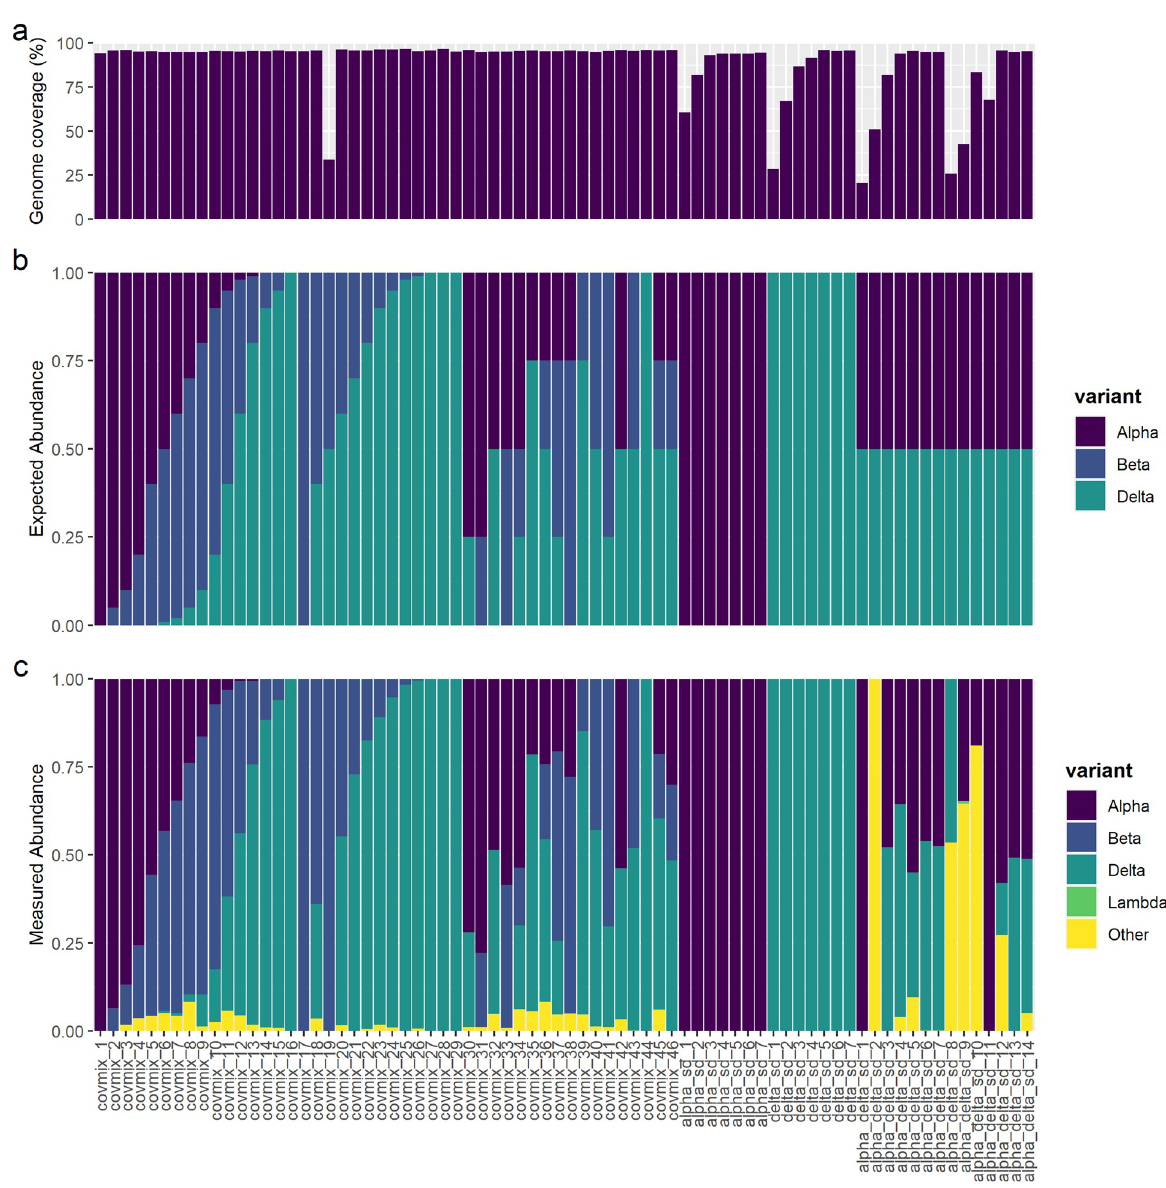
Fig 6. Wastewater sequencing protocol can successfully decipher synthetic SARS-CoV-2 variant mixtures. (a) Percentage genome coverage obtained for each synthetic SARS-CoV-2 RNA sample. (b) Expected abundances based on the concentration of each synthetic variant in each sample. (c) The measured abundance of each variant from analysis of sequencing data using